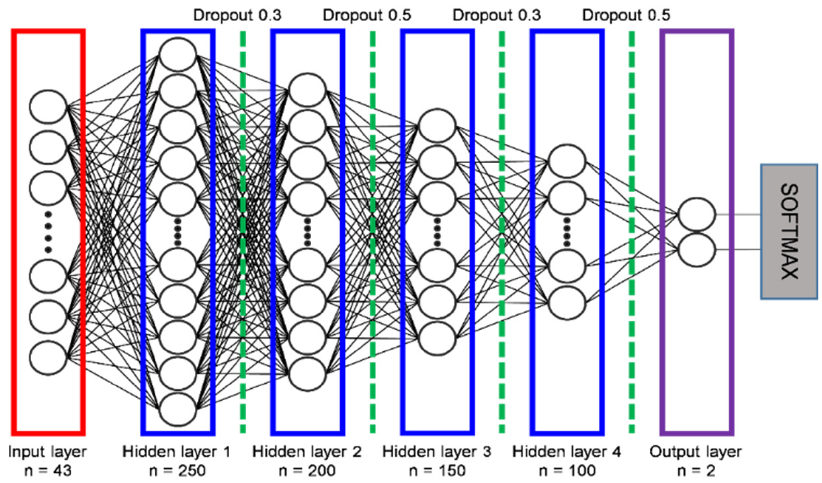
Figure 3. Construction of the DNN model used in Stage 1 of the present study.